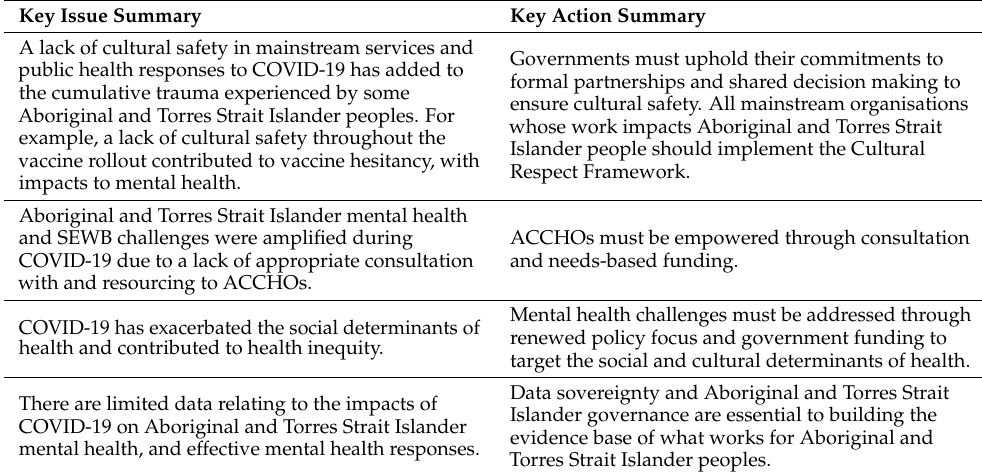
Table 1. Summary of the key issues and actions